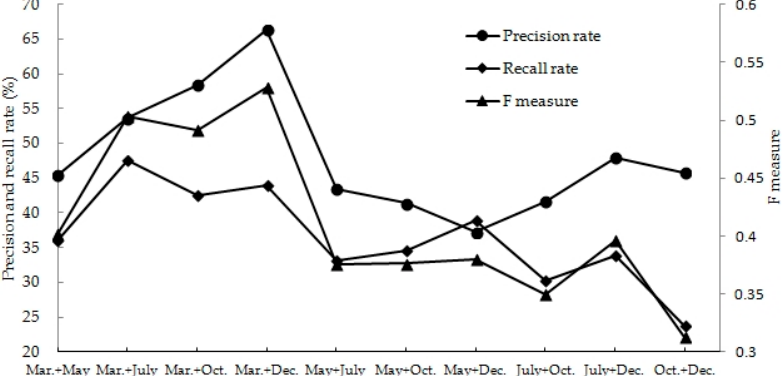
Figure 7. Precision rate, recall rate, and F measure values for the detection of QVPs from the ten combined two-season images using ten predictive variable selection datasets listed in Table 6.